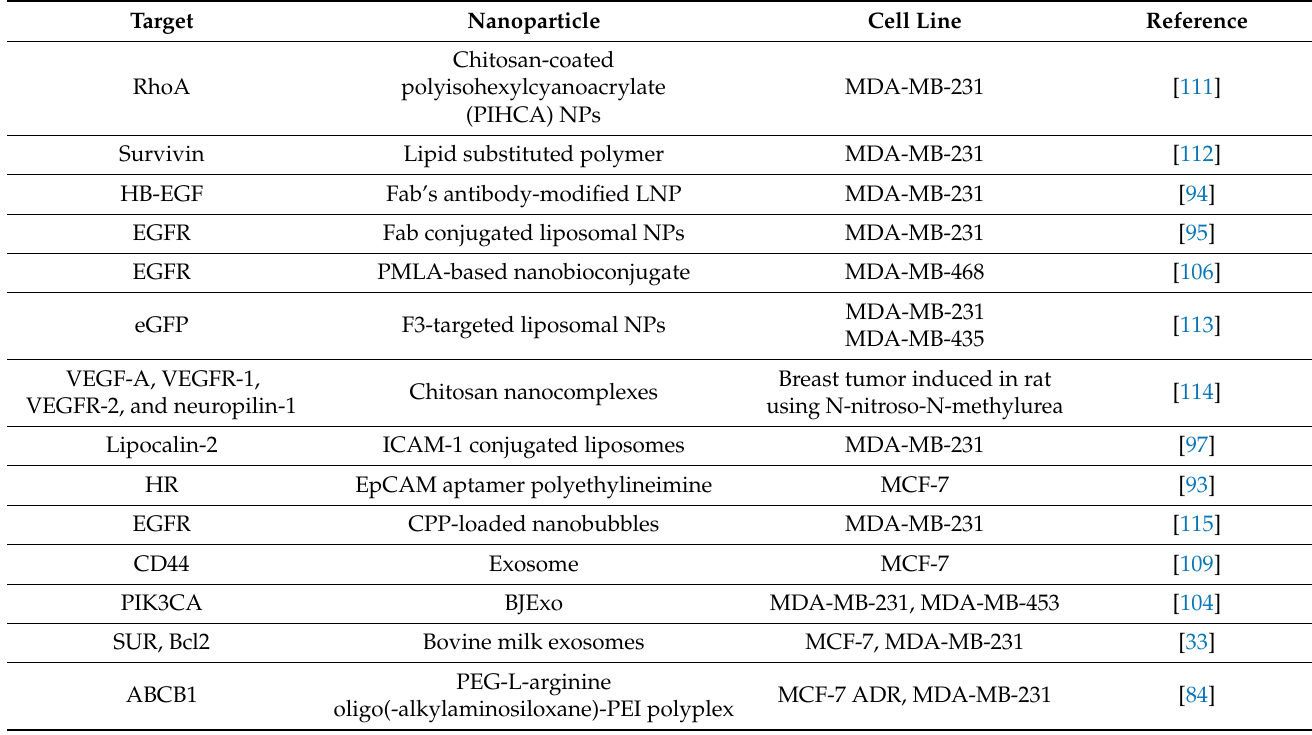
Table 2. Preclinical studies of selected biopolymer-induced siRNA delivery platforms for breast cancer